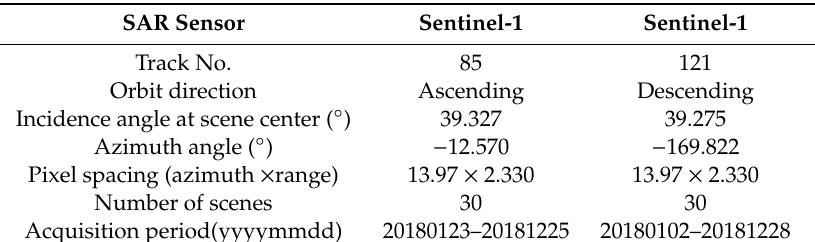
Table 1. The principal parameters of the synthetic aperture radar (SAR) datasets.